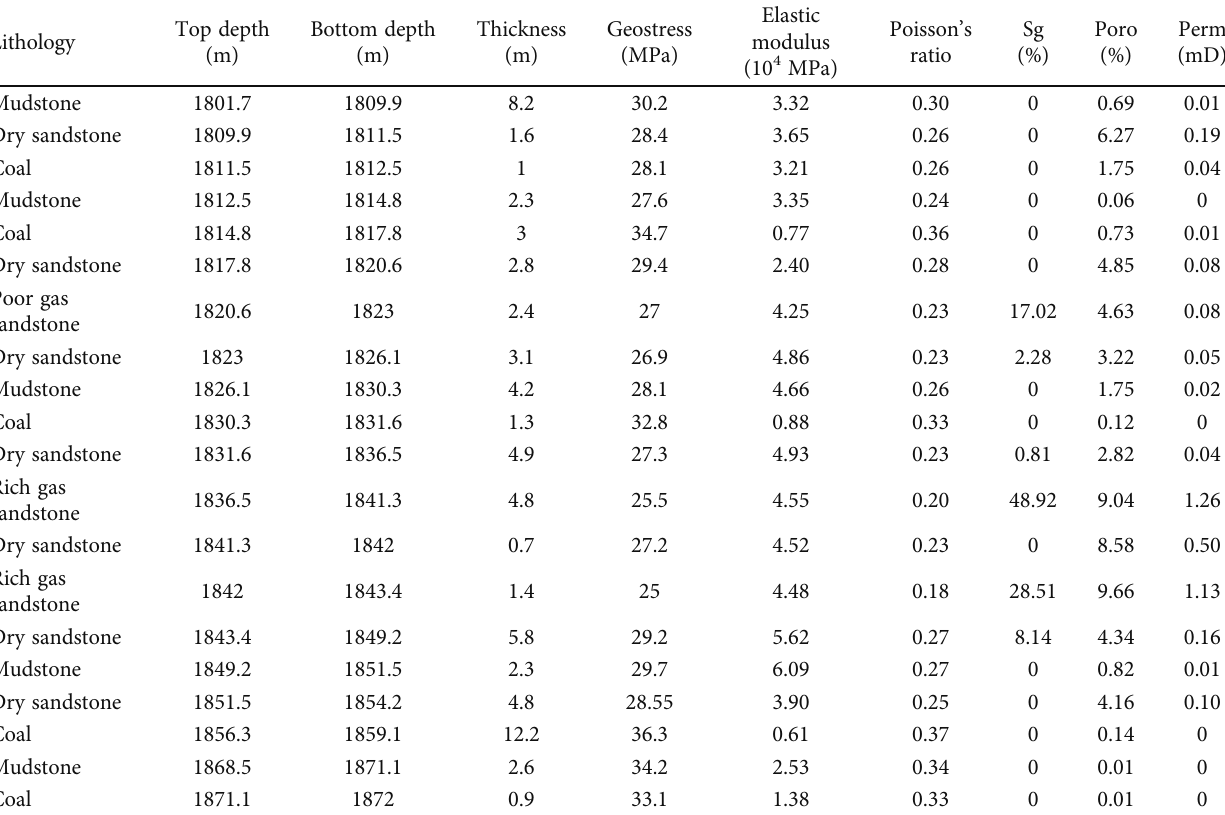
Table 4: Lithologies and geological parameters of di ff erent layers in Taiyuan formation of well X-1.